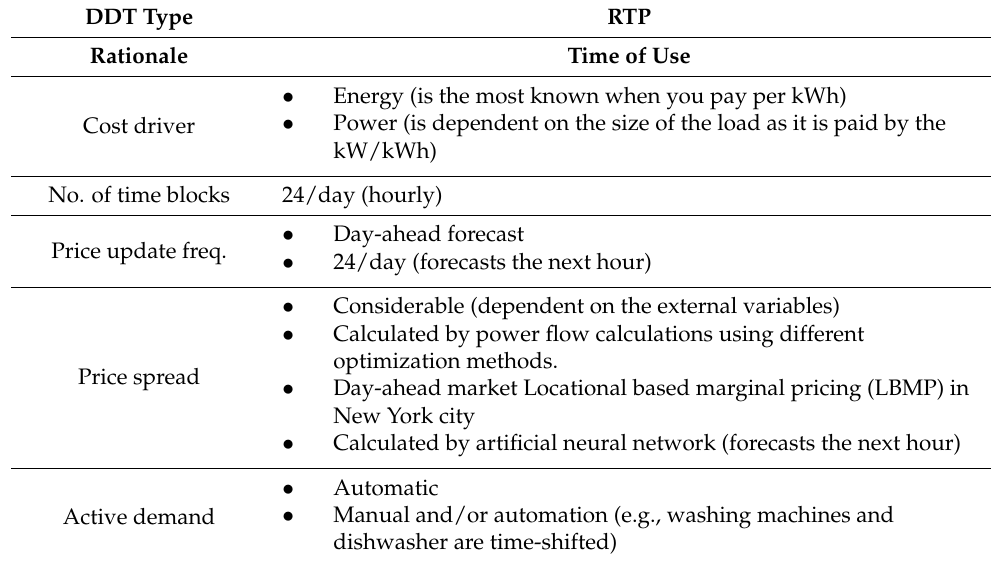
Table 4. The characteristics of RTP in the